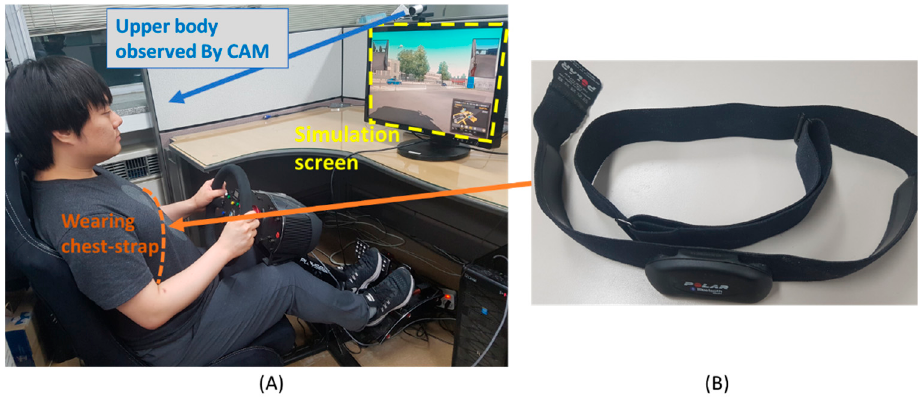
Figure 3. ( A ) The virtual driving environment; ( B ) a wearable chest-strap electrocardiogram (ECG) device for heart rate variability (HRV) data collection.